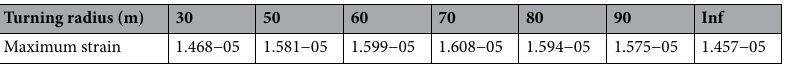
70 m. The strain then ∼